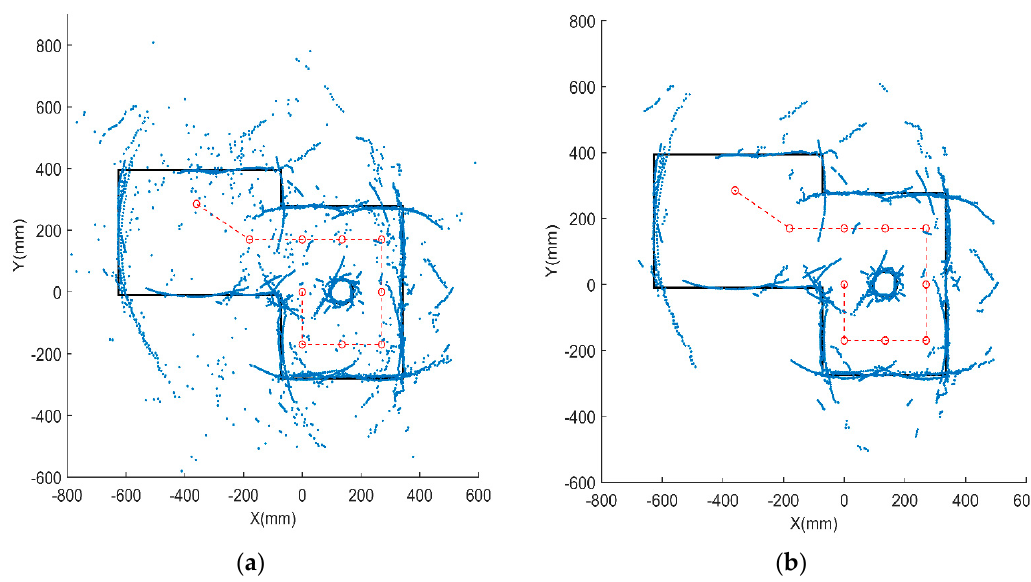
Figure 10. Preprocessing of original data. ( a ) Original distance dataset; ( b ) distance dataset after preprocessing.